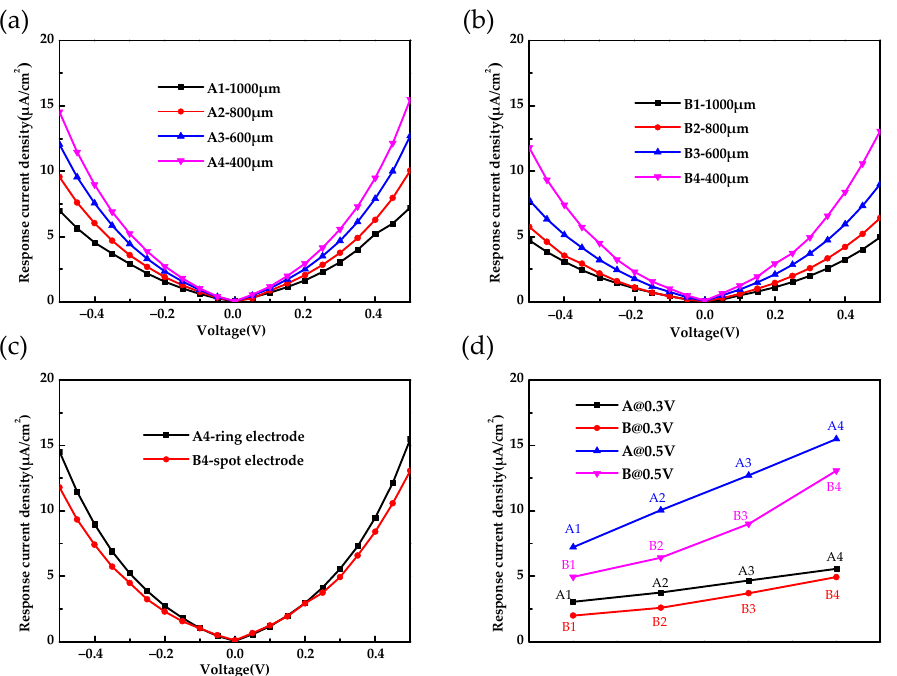
Figure 3. The blackbody response current density-voltage characteristics of ( a ) A detectors and ( b ) B detectors. ( c ) Comparison of the response current density of the A4 and B4 detectors. ( d ) The response current density of the different detectors at 0.3 V and 0.5 V.